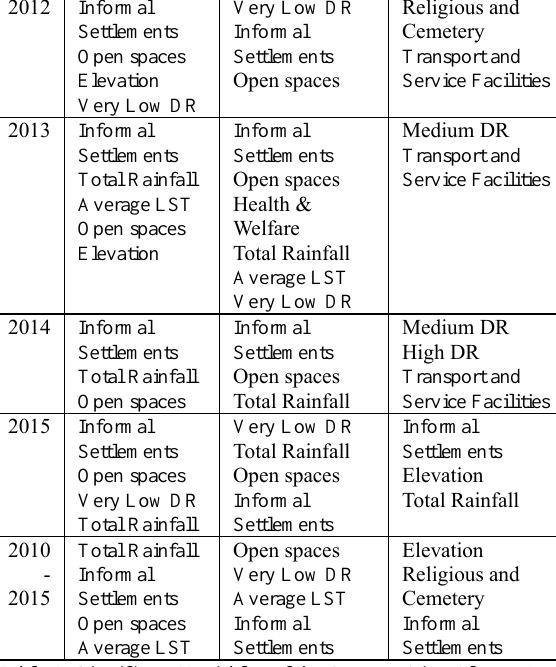
Table 2. Significant Variables of the Quezon City, Cluster 1 and